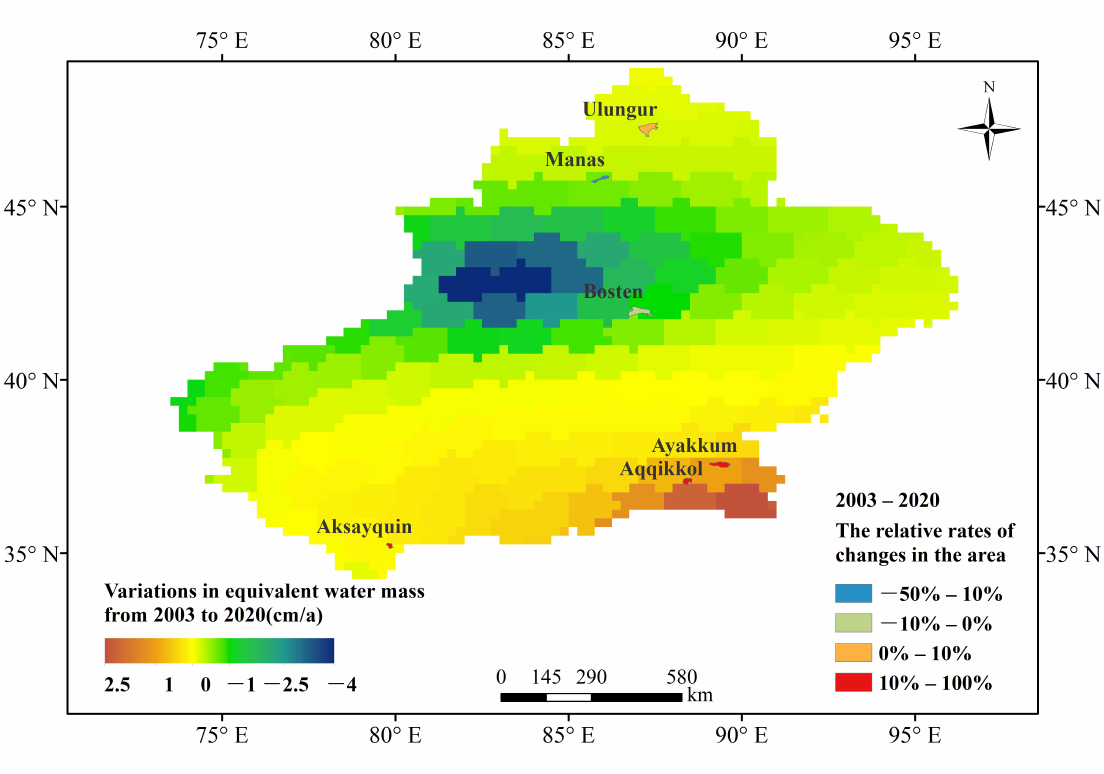
Figure 7. Variations in equivalent water mass on Xinjiang from GRACE satellite